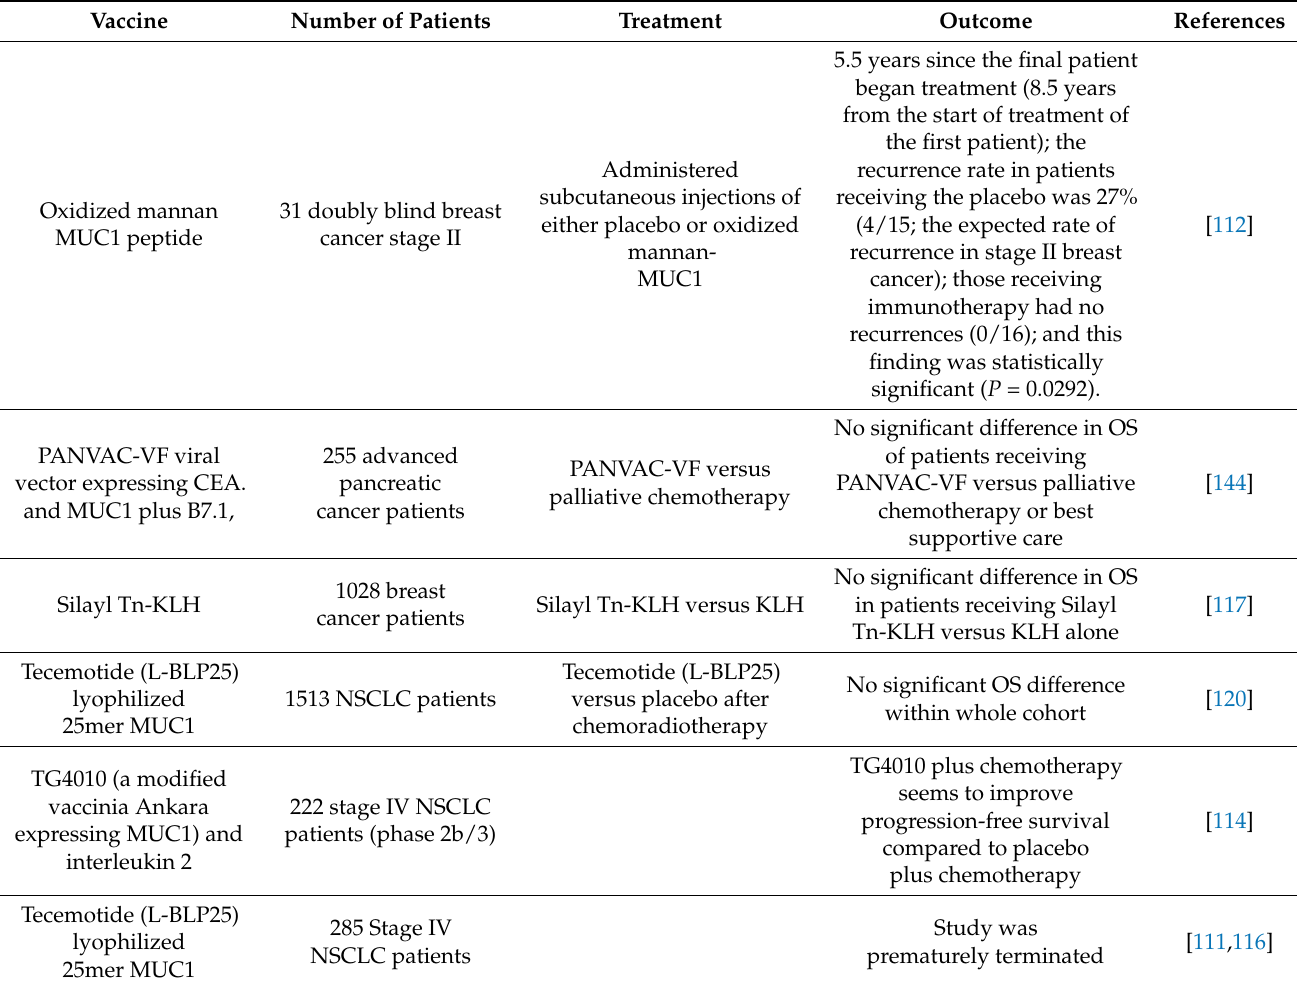
Table 2. List of Phase III clinical trials using MUC1 antigen (retrieved from clinicaltrial.gov website, accessed on 9 September